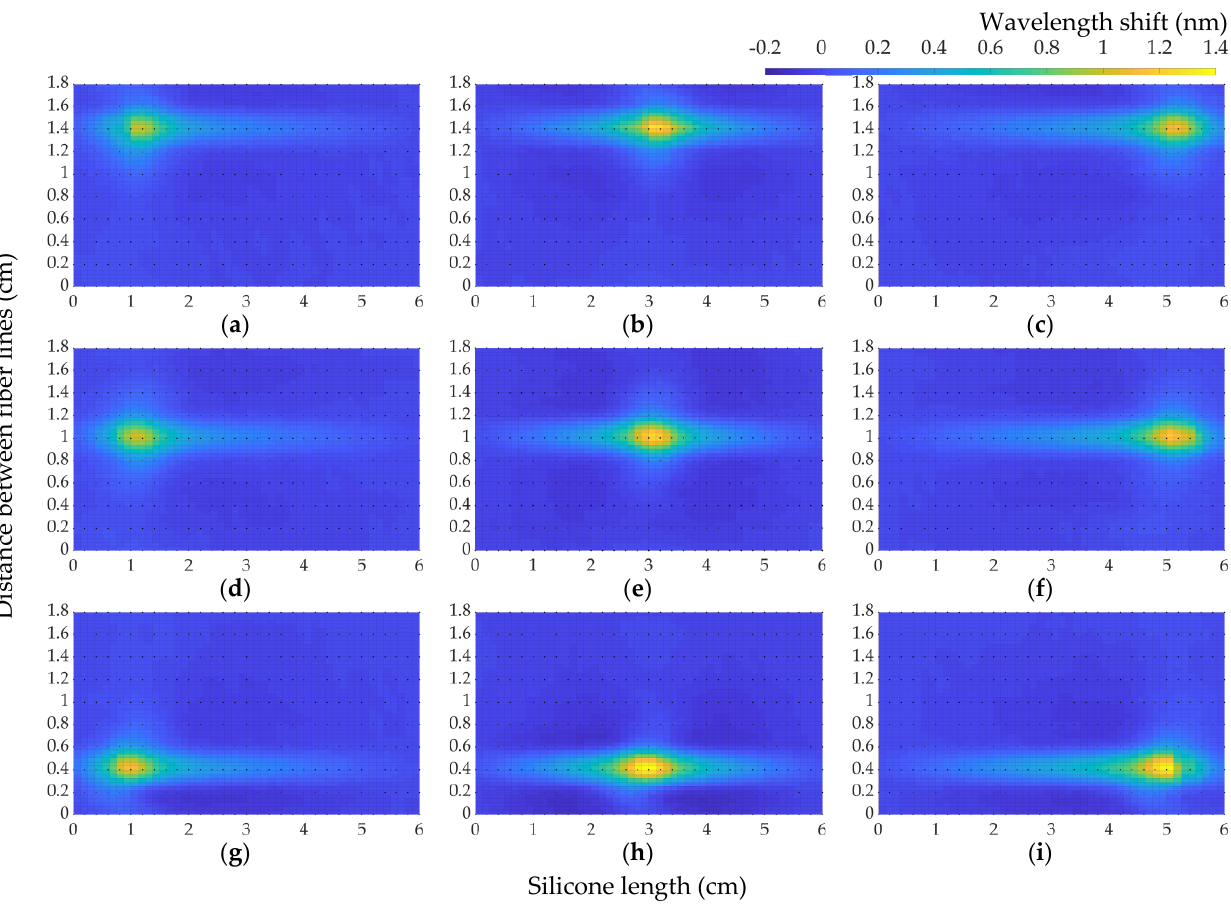
Figure 11. The measurements on wavelength shift over the embedded fiber in silicone carpet: ( a ) “A5”, ( b ) “C5”, ( c ) “E5”, ( d ) “A9”, ( e ) “C9”, ( f ) “E9”, ( g ) “A15”, ( h ) “C15”, and ( i “E15” Nevertheless, the variance in the wavelength-shift values of the chosen coordinates is low, 0.0168. Table 2 represents the statistical values of the wavelength shift for nine locations on the sensing carpet. Table 2. The statistical values of the chosen points of the sensing carpet.